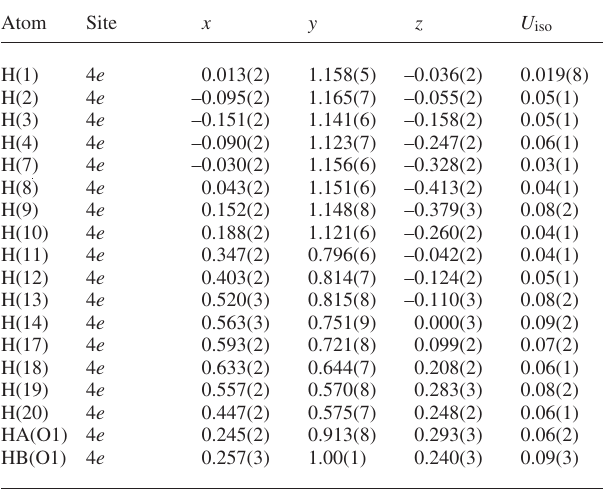
Table 2. Atomic coordinates and displacement parameters (in Å 2 )